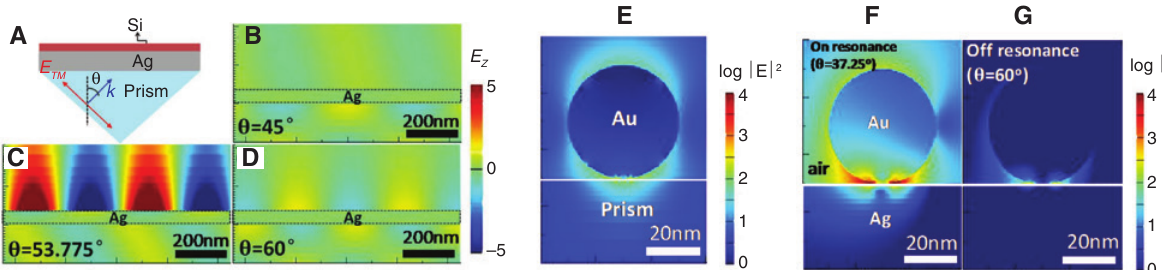
Figure 17: Spacer layer effect under ESP-LSP coupling in prism